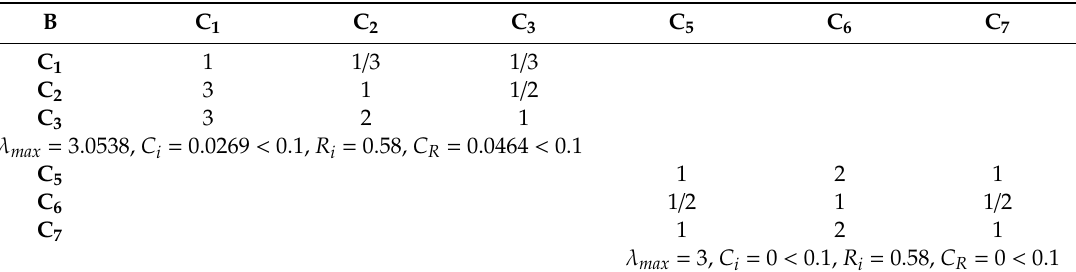
Table 8. Judgment matrix of indicator layer (layer